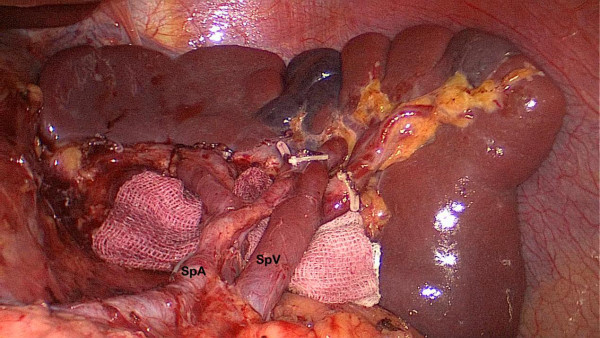
Dissection of the lymph node numbers 11d and 10. SpA: splenic artery; SpV: splenic vein.